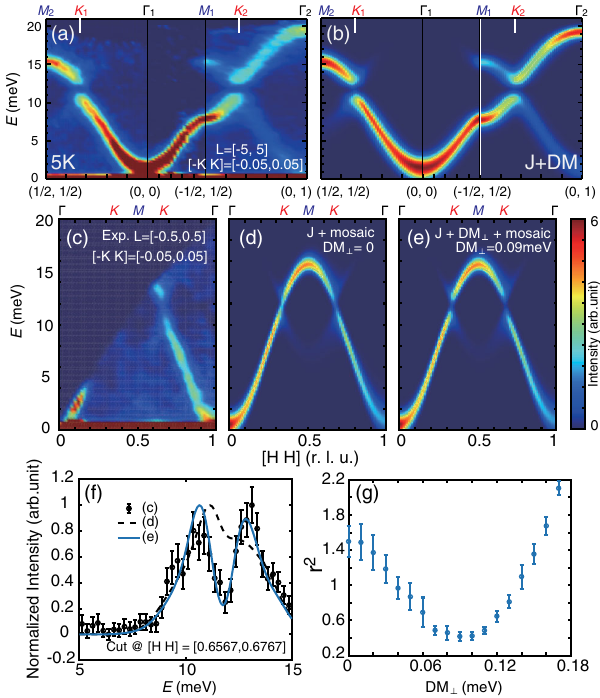
FIG. 3. The Heisenberg-DM model fit of CrI 3 E - Q spin wave spectrum. High-symmetry points are labeled. (a) Experimental data at 5 K. (b) Heisenberg-DM model simulation using param- eters in Table I. (c) Experimental data at 5 K with smaller L integration range. (d, e) Heisenberg-DM model simulations including sample mosaic with (d) DM ¼ 0 and (e) DM ⊥ ¼ 0 . 09 meV. (f) Constant- Q cuts of the data in (c – e) at the Dirac point ð 2 = 3 ; 2 = 3 ; 0 Þ . (g) The squared error r 2 between experi- mental and simulation values of the Dirac point cut as a function of the DM interaction strength. This result is mostly due to the reduced mosaicity of the coaligned single crystals (an in-plane mosaic full width at half maximum of 8.0° compared with that of about 17° in Ref. [30]) and improved instrumental resolution [43].